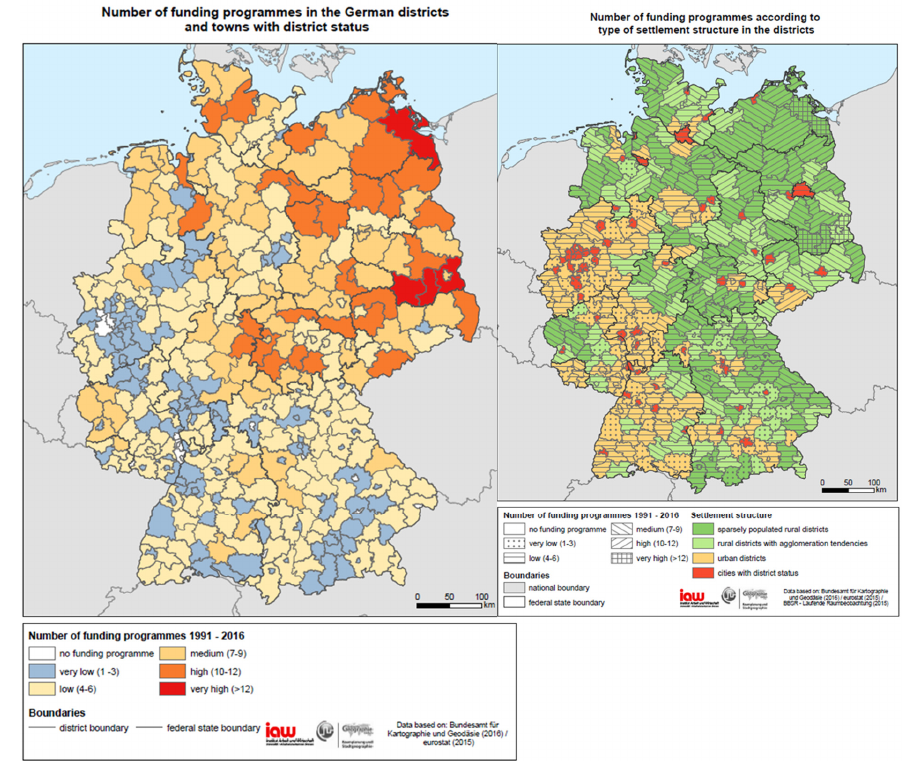
Figure 5. Number of funding programmes in the German districts and towns with district status (left) and number of funding programmes according to type of settlement structure in the districts (right). Source: authors’ compilation (Department of Geography Giessen, Institute for Labour and the Economy